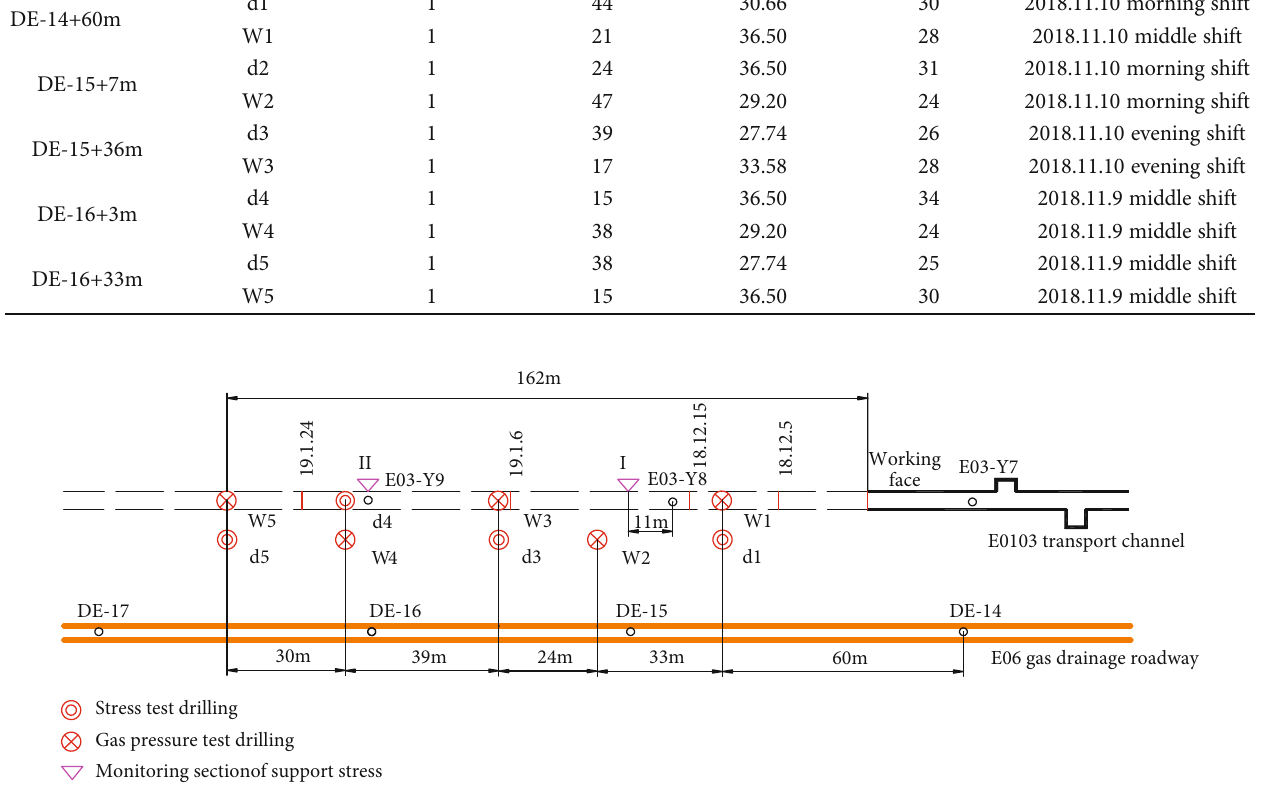
Figure 8: Layout plan: measuring points in the E0103 transport